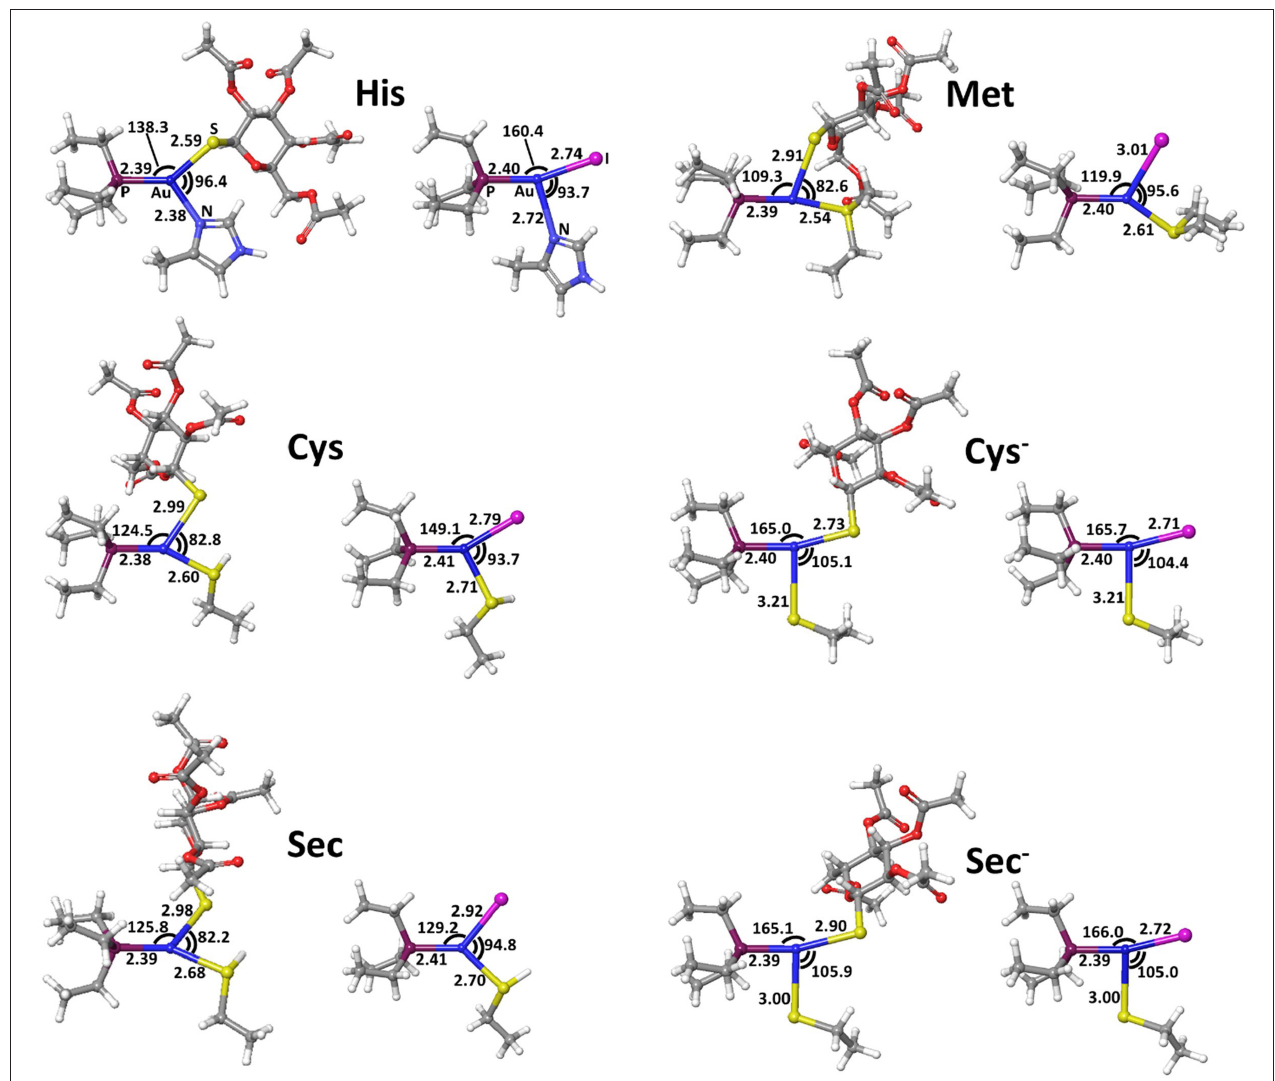
FIGURE 5 | Transition states for thiosugar or iodide substitution by all considered amino